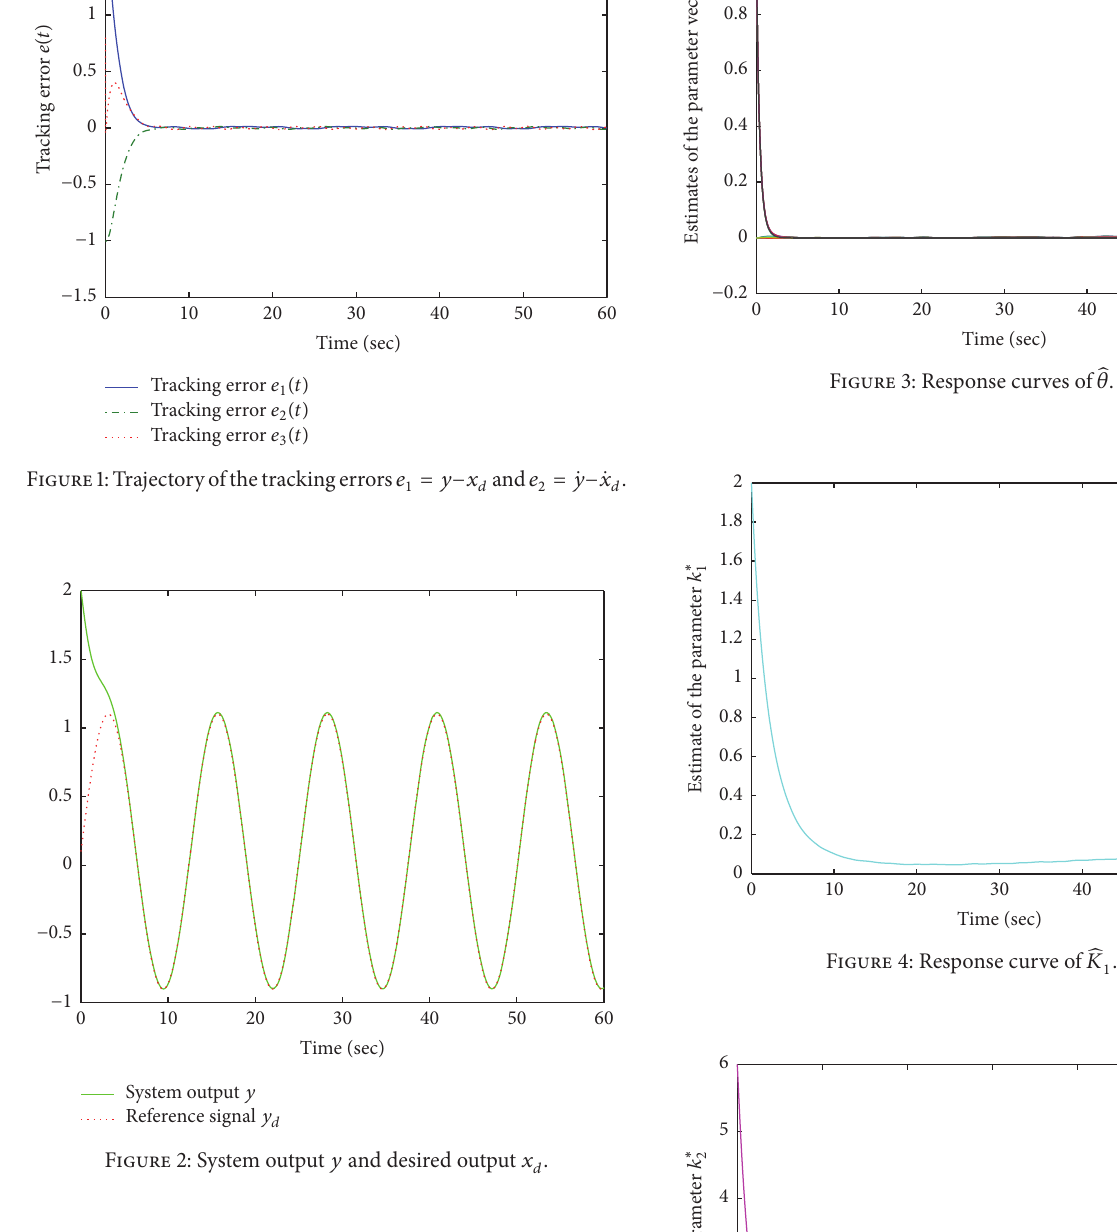
Figure 2: System output 𝑦 and desired output 𝑥 𝑑 .